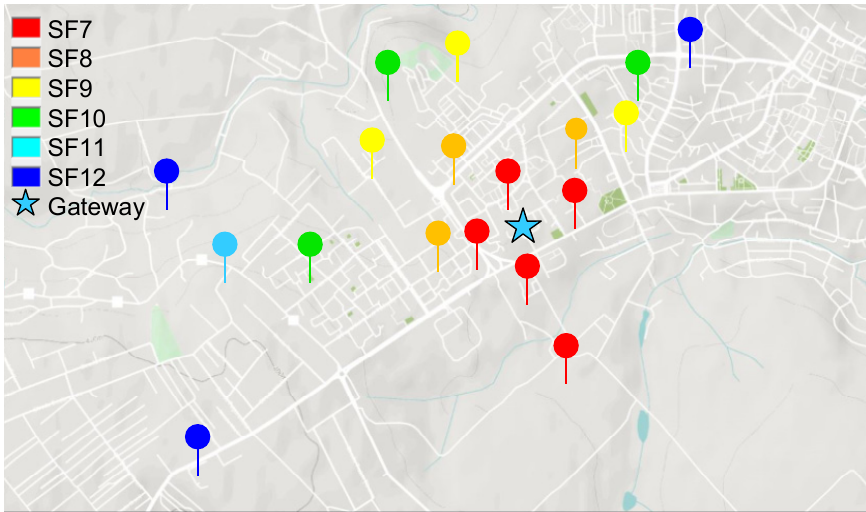
Figure 8. Field coverage measurements of the LoRaWAN gateways installed on the roof top of Suceava Hospital.